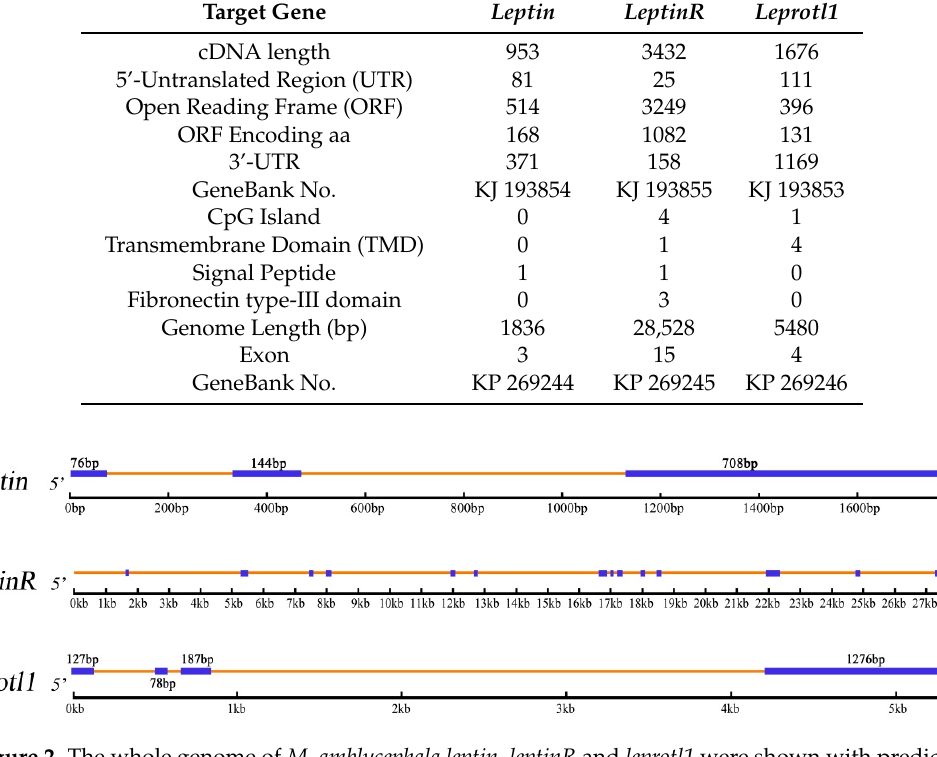
Figure 2. The whole genome of M. amblycephala leptin , leptinR and leprotl1 were shown with predicted coding exons and introns with their length. The exons were represented by blue threads and introns were represented by yellow threads.